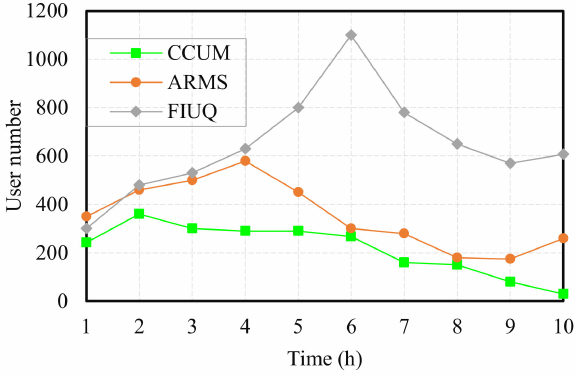
Figure 6. The number of users.